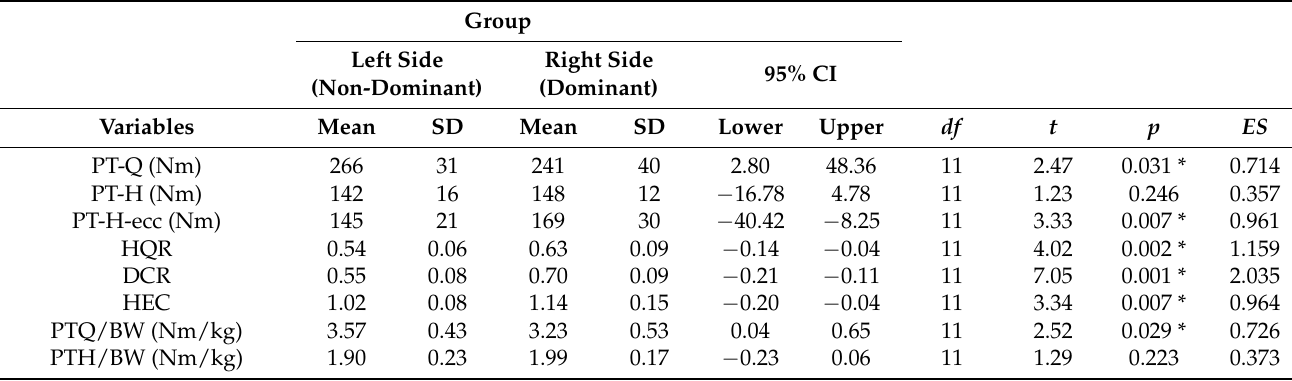
Table 1. Mean ( ± SD) values for L and R quadriceps (Q) and hamstring (H) concentric and hamstring eccentric (PTHecc) peak torques (PT), PT per kg of weight (PT/BW) and strength ratios (HQR, DCR and HEC) at 60 ◦ /s with paired t -test.